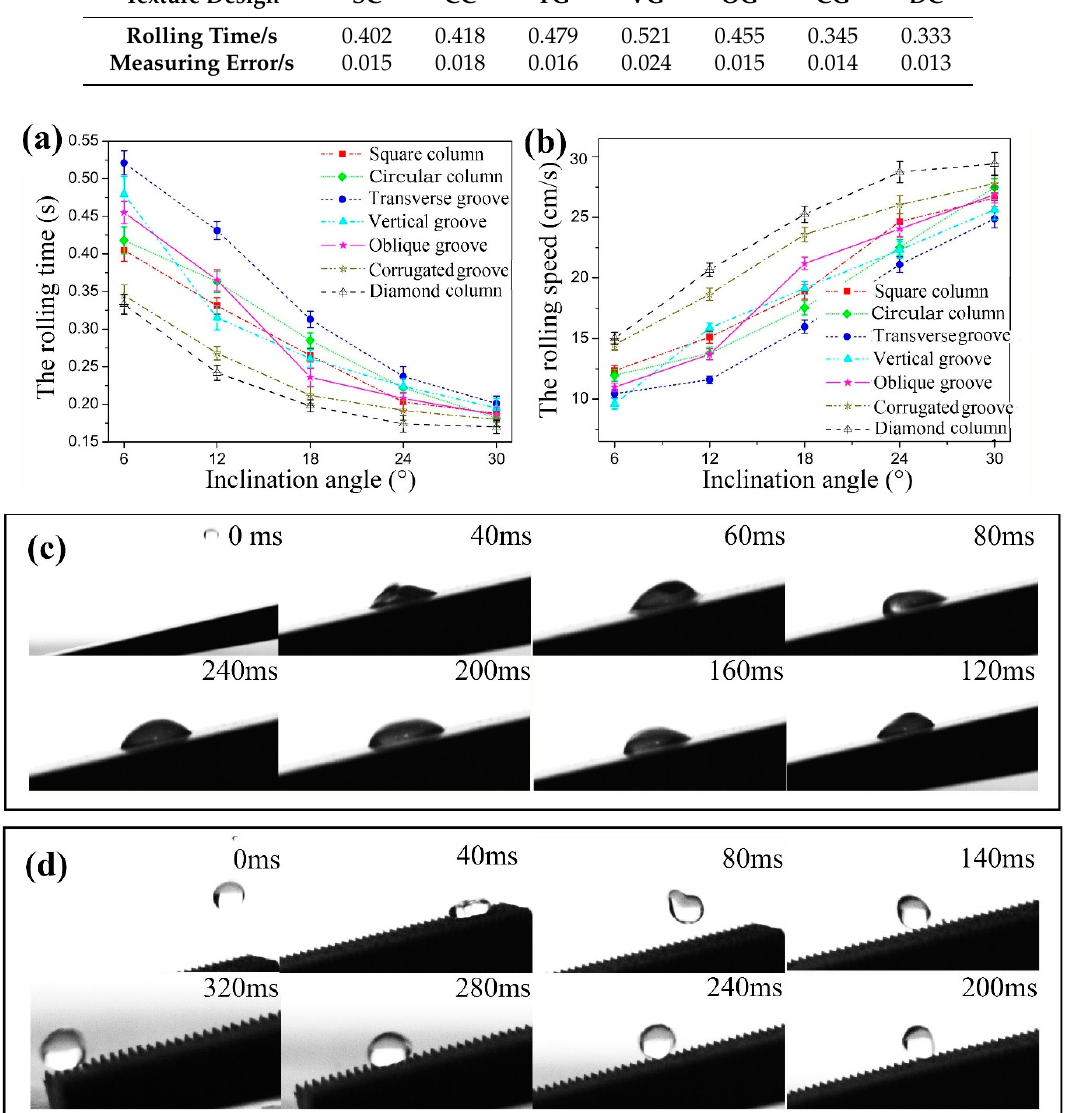
Figure 11. ( a ) Rolling time and ( b ) rolling speed of the droplet dripping on the different textured surfaces against inclination angle and instantaneous snapshots of a droplet dropping onto ( c ) original sample and ( d ) diamond column textured